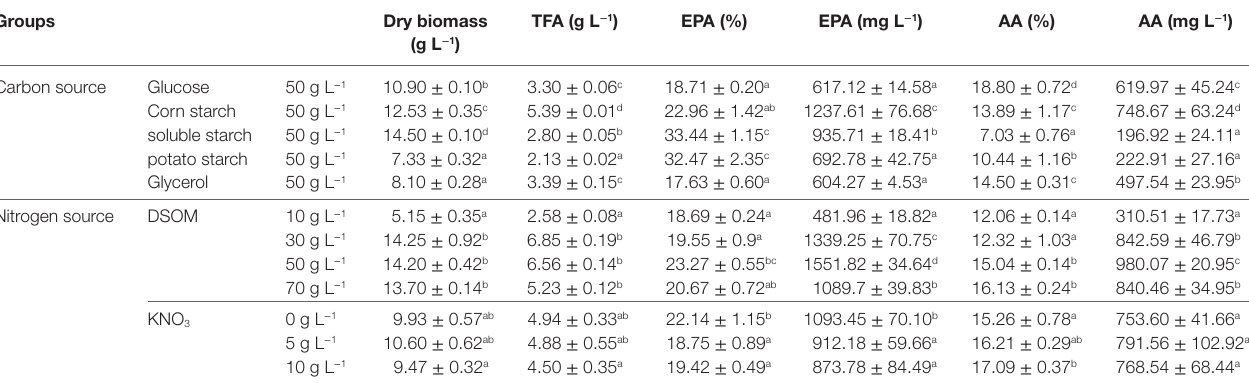
TaBle 3 | Effect of culture medium on biomass, total lipid, and EPA production by M. alpina CCFM 695. groups